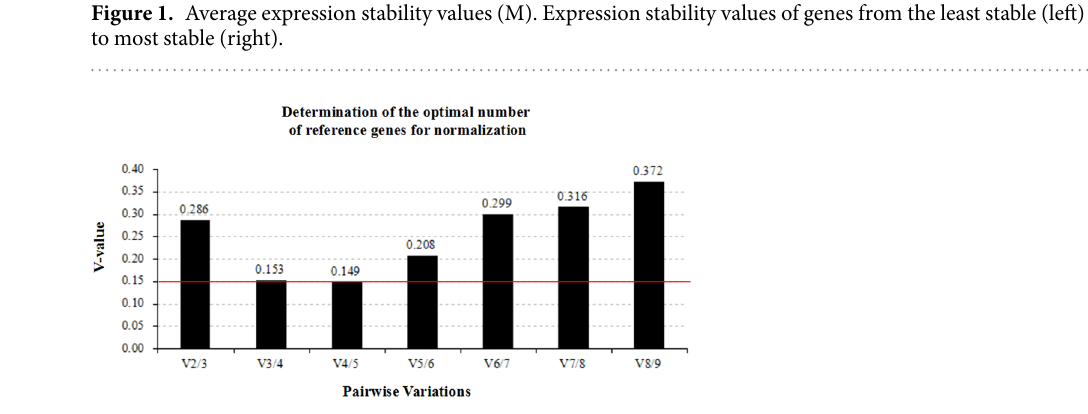
Figure 2. Pairwise variation of candidate reference genes using geNorm analysis. Pairwise variation analysis to determine the optimal number of reference genes for